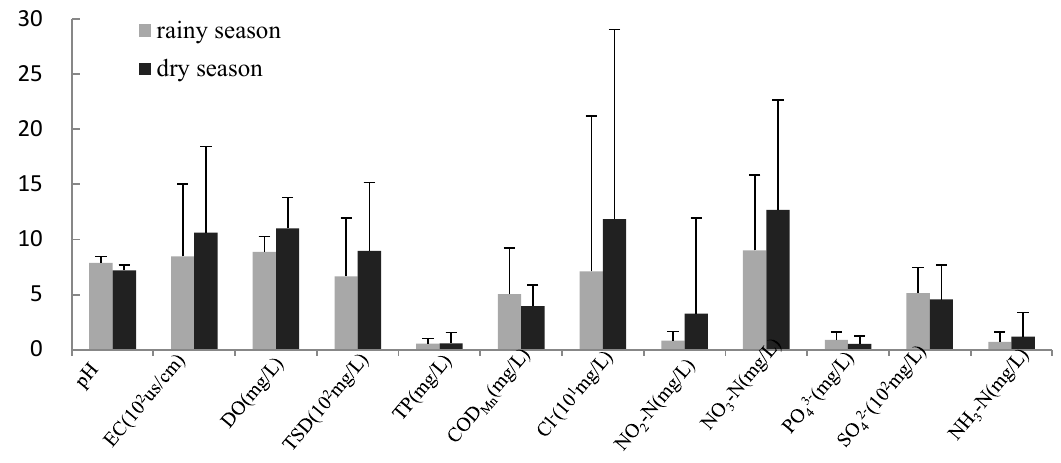
Fig. 3 Physical-chemistry water quality properties in the Wei River basin. Error bars in this figure means standard deviation of each water quality